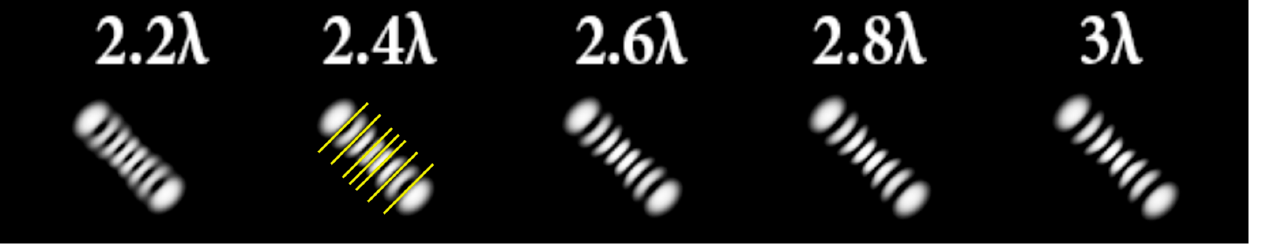
Figure 3. Detailed simulation results for multi-channel DOEs matched with one type of aberration Z 4,2 ( r , ϕ ) with α ranging from 2.2 λ to 3 λ when illuminated by a vortex beam with TC l = 7.